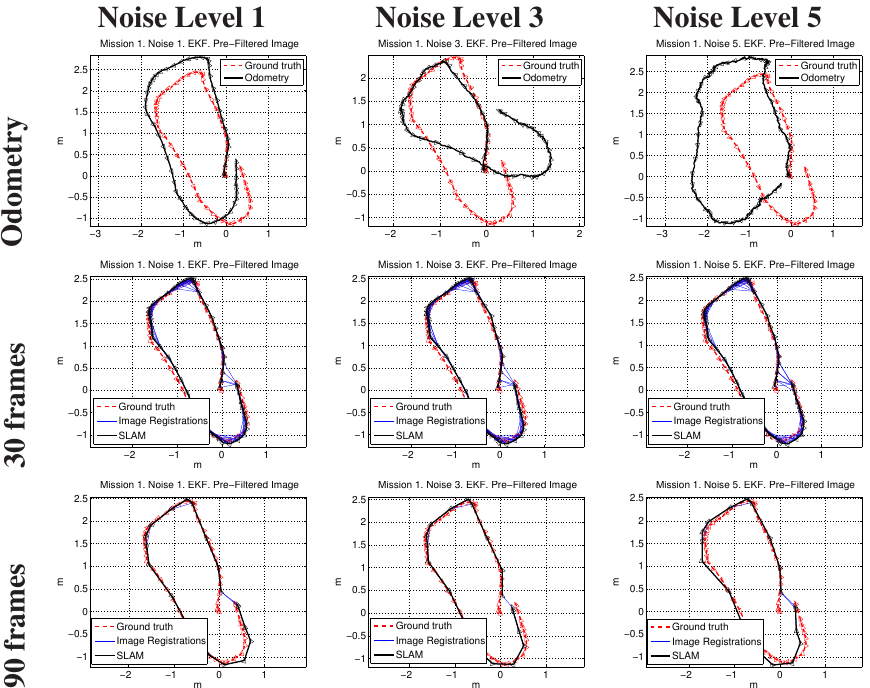
Figure 14. Example results corresponding to the first mission. The first row compares visual odometry and ground truth. The next rows correspond to different keyframe separations. The first, second and third columns are related to Noise Levels 1, 3 and 5, respectively.